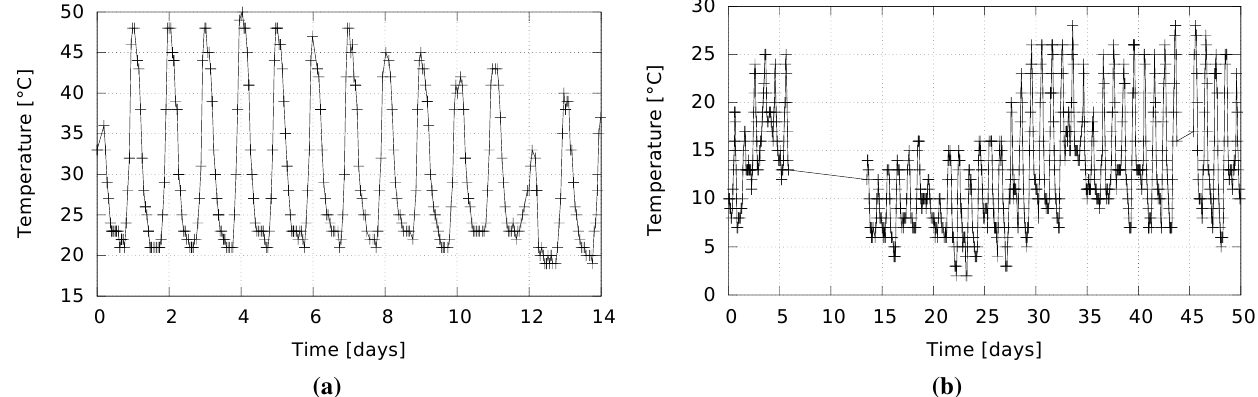
Figure 12. Gateway temperature can exceed 45 ◦ C, the maximum allowed for lithium-ion battery charging ( a ), while the internaloscillator drift can break the synchronous serial communication with the GPRS modem at low temperatures (Days 6–13 and 43–45) ( b